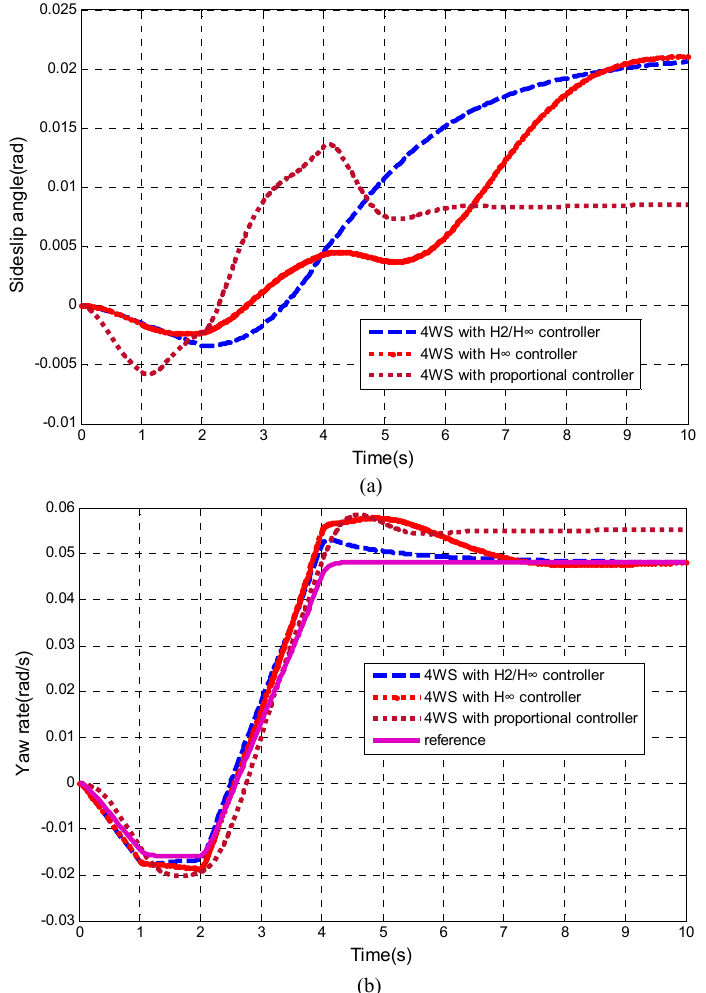
Figure 23. The fishhook maneuver simulation results: ( a ) sideslip angle response; ( b ) yaw rate response.